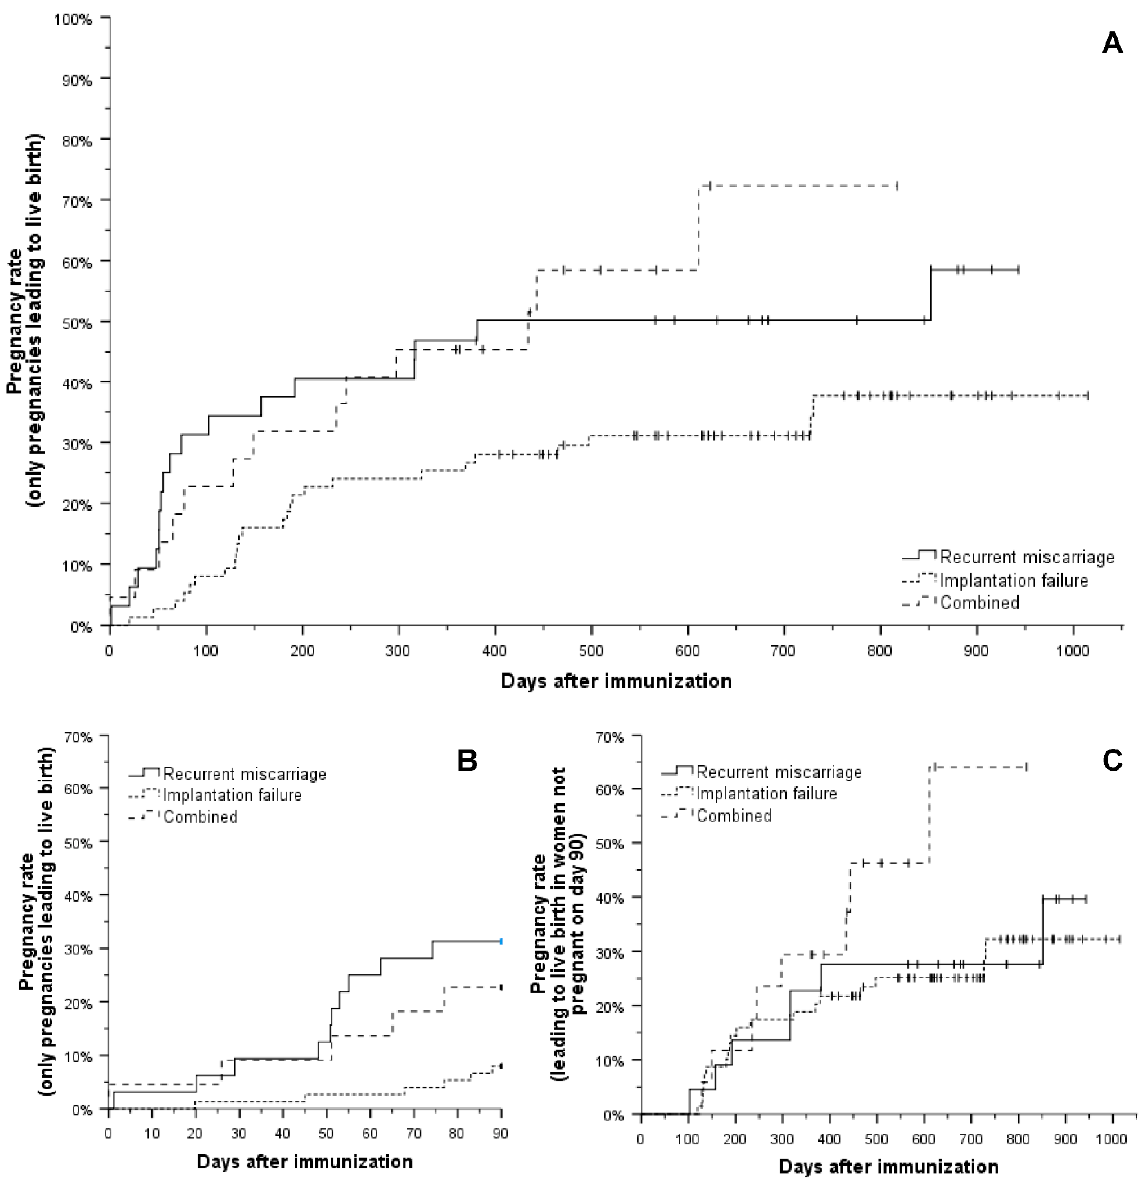
Figure 2. Conception rate after immunization resulting in a live birth. ( A ): The pregnancy rate leading to live birth was lower in patients with implantation failure only (overall p = 0.02, p = 0.03 compared to patients with recurrent miscarriage, p = 0.008 compared to patients with combined recurrent miscarriage and implantation failure), but not different between patients with recurrent miscarriage and those with combined recurrent miscarriage and implantation failure ( p = 0.65). ( B ): Pregnancy rates differred mainly during the first 90 days after immunization, with lower rates in patients with implantation failure only (overall p = 0.005; p = 0.001 compared to patients with recurrent miscarriage, p = 0.04 compared to patients with combined recurrent miscarriage and implantation failure), but no significant difference was observed between patients with recurrent miscarriage and patients with combined recurrent miscarriage and implantation failure ( p = 0.49). ( C ): There was no significant difference in pregnancy rates leading to live birth after day 90 post immunization (overall p = 0.18). Table 2. Newborn